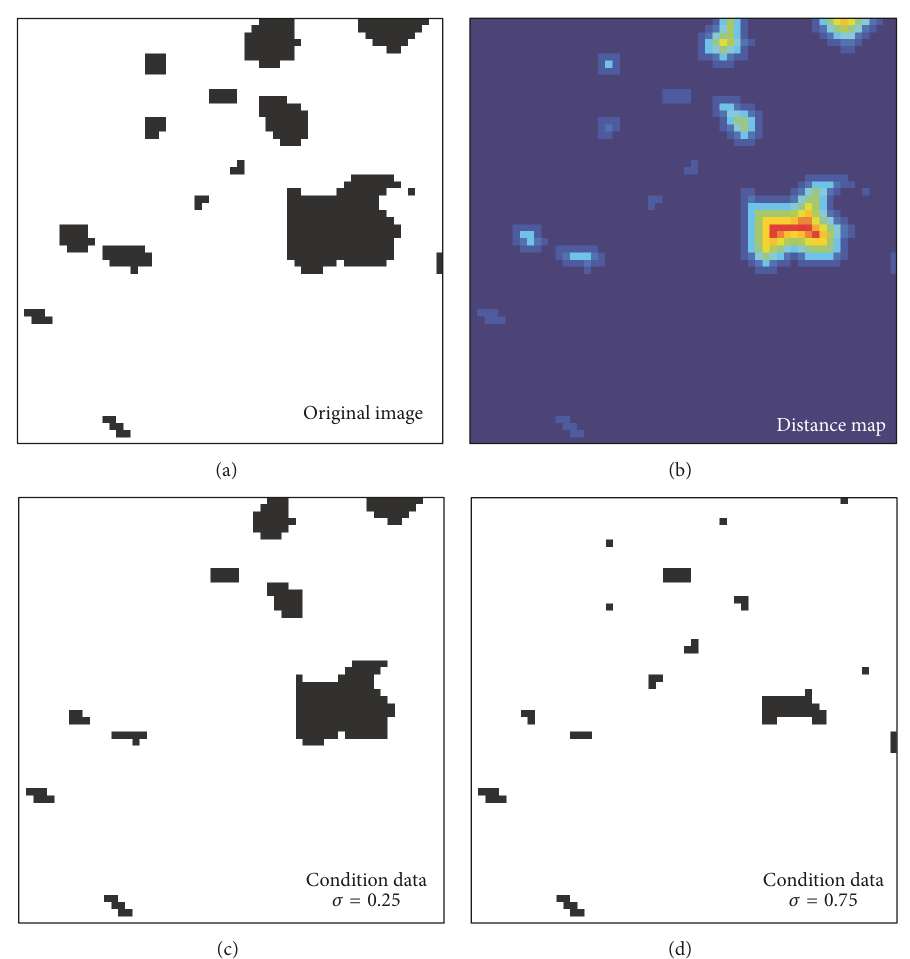
Figure 5: Workflow of generating the conditioning data used in the MPS approach. (a) The original image. (b) The calculated distance map based on the original image shown in (a). (c) The generated conditioning data for 𝜎 value of 0.25 and (d) for 𝜎 value of